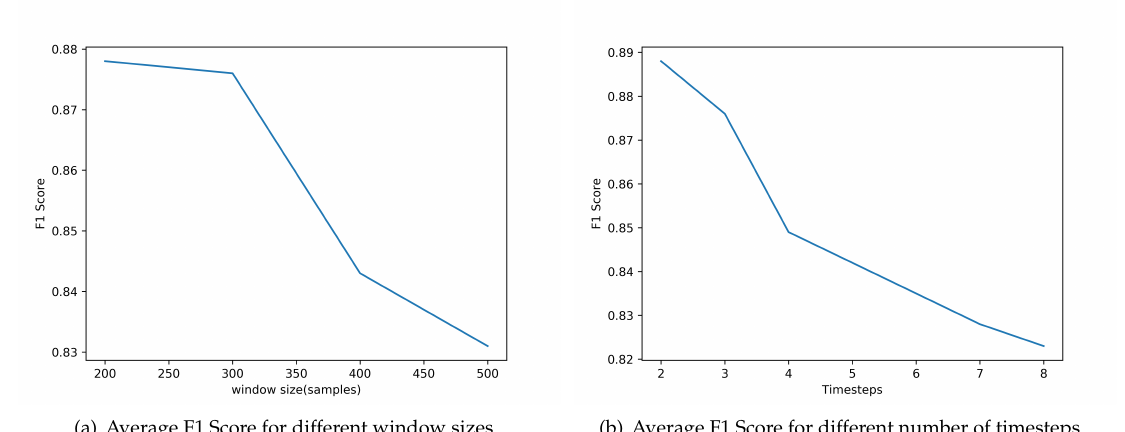
Figure 6. Evaluation of the classifier parameters regarding Window size and number of Timesteps based on the performance achieved using the average F1